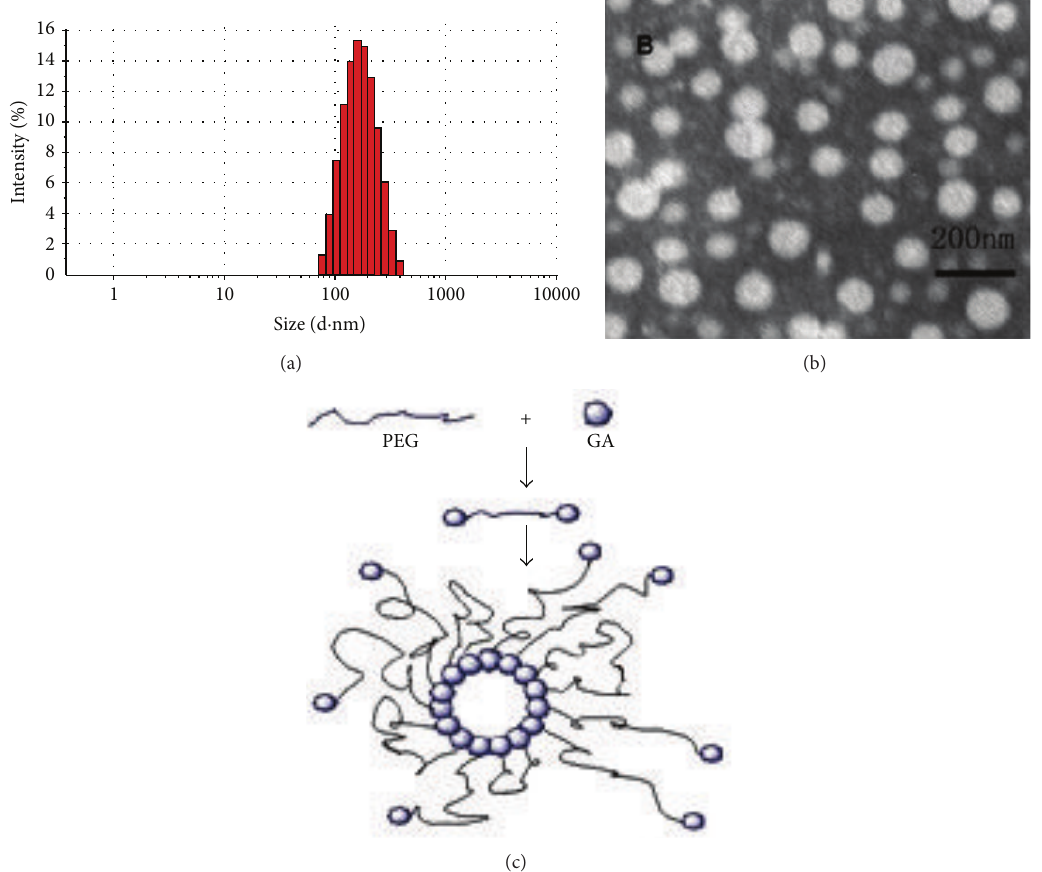
Figure 4: Preparation and characterization of the paclitaxel loaded GA-PEG-GA micelles. (a) Size distribution of the paclitaxel loaded GA- PEG 2000 -GA micelles (GA-M-PTX); (b) TEM image of GA-M-PTX (size of the scale bar: 200nm); (c) diagram of the preparation of GA- PEG-GA